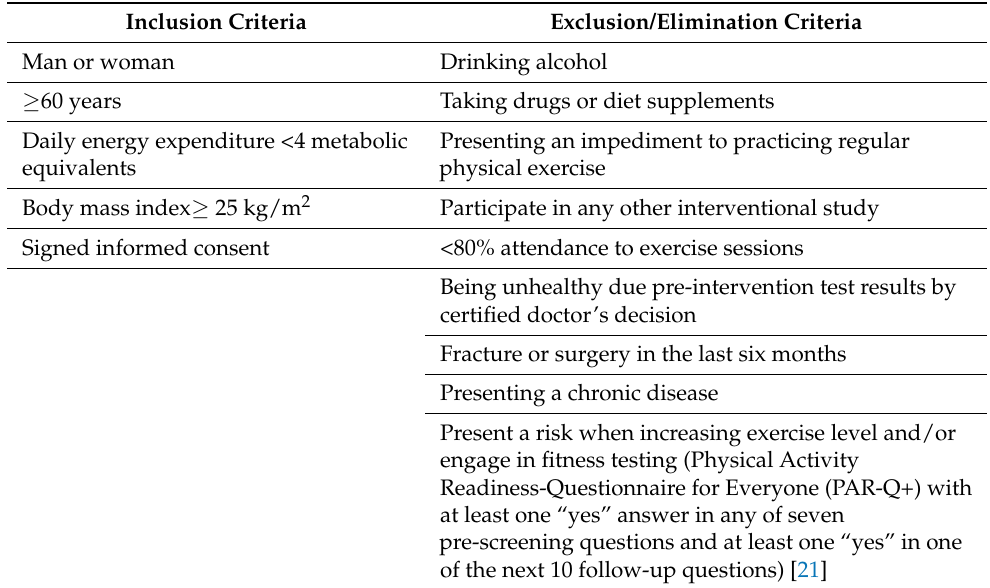
Table 1. Inclusion and exclusion/elimination criteria to participate in the Spirulina maxima intake and exercise (SIE) randomized controlled